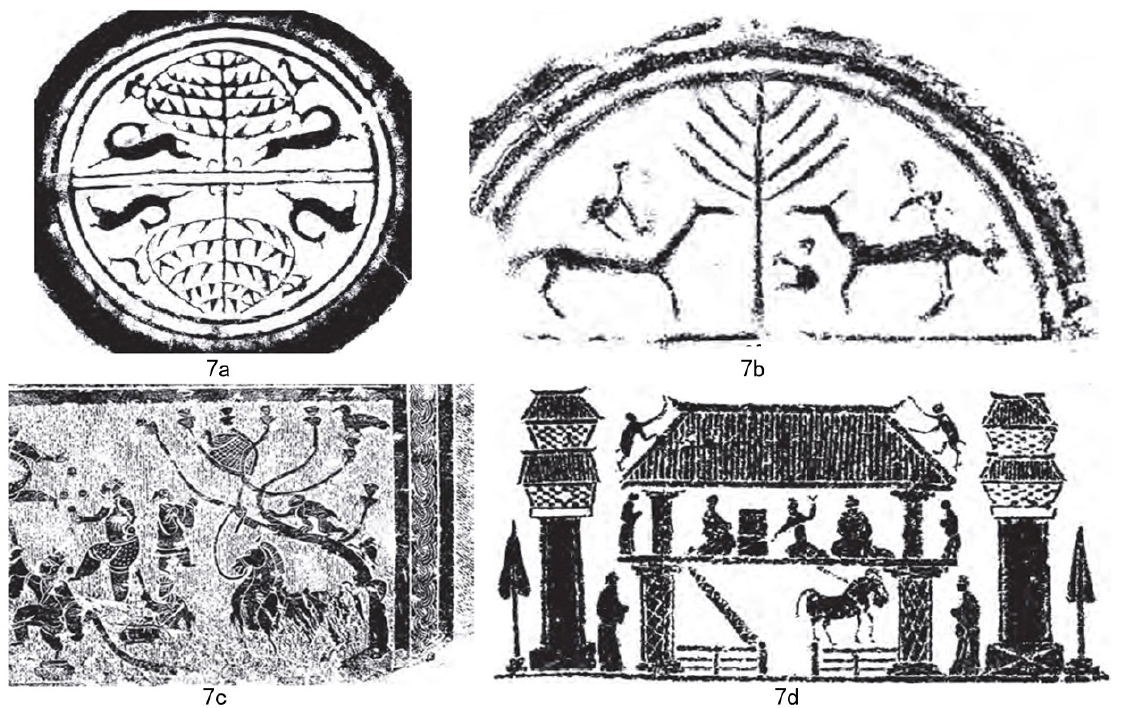
Figure 7. Monkeys and horses in archives: a) Rubbing of eaves tile shows connection of horse and monkey (An 1998); b) Rubbing of eaves tile shows connection of horse and monkey (Fu 2002); c) Han carving, depicting horse breeding and monkey (Xu 2017); d) Han carving, depicting horse breeding and monkey (Xu 2017).